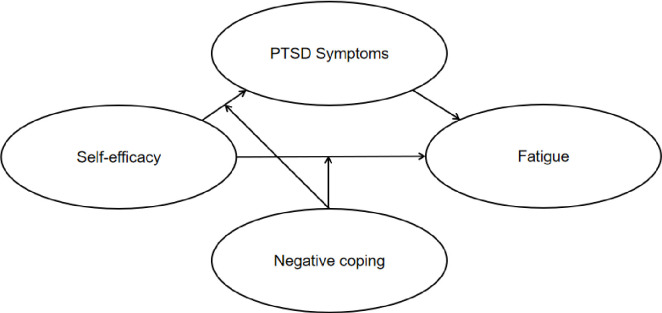
The schematic model of proposed moderated mediation model.